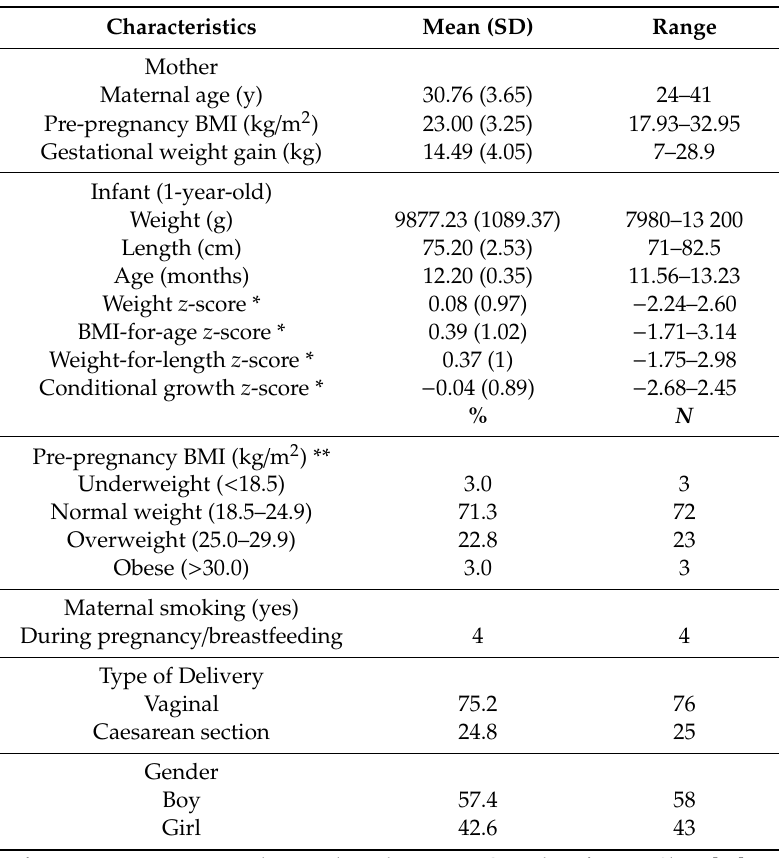
Table 1. Maternal and infant characteristics ( n = 101). BMI—body mass